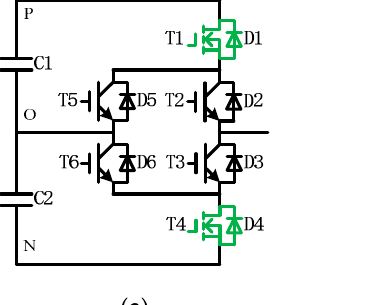
Table 1. Switching status of the proposed ANPC topology.